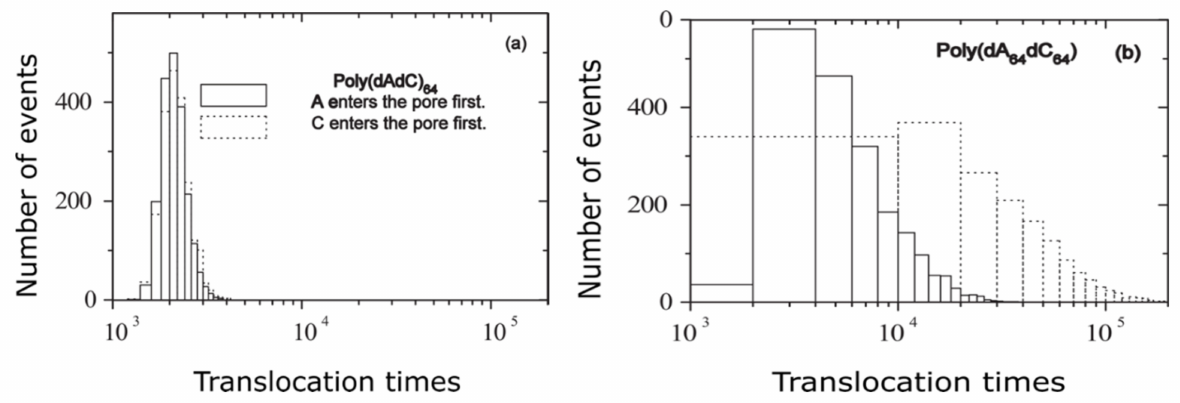
Figure 7. Translocation times histogram: ( a ) poly(dAdC) 64 and ( b ) poly(dA 64 dC 64 ) under F = 0.5